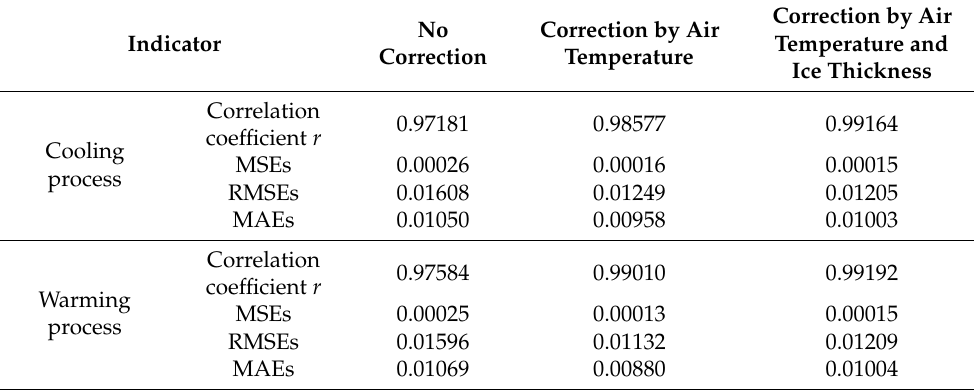
Figure 11. Statistical diagram of effects of radar-detected ice thickness before and after correction in ( a ) warming and ( b ) cooling processes of air temperature. Table 4. Correlation coefficient and errors of the simulated and measured ice thickness after correction and the radar-detected ice thickness before and after correction.